Question: What form of chart is displayed?
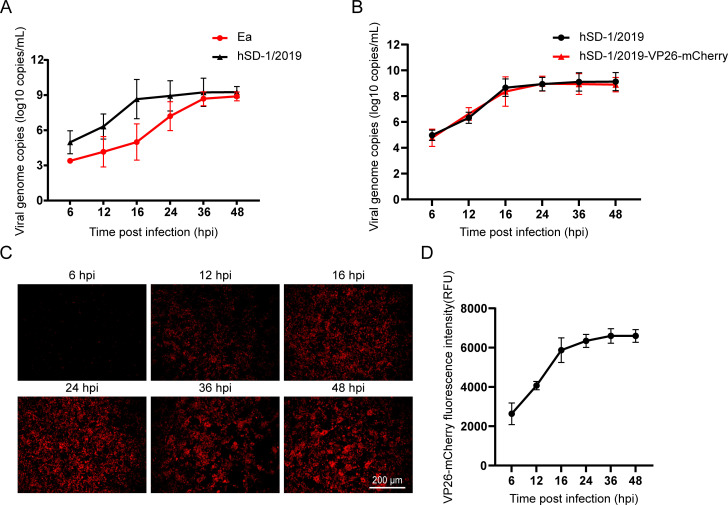
Answer: line